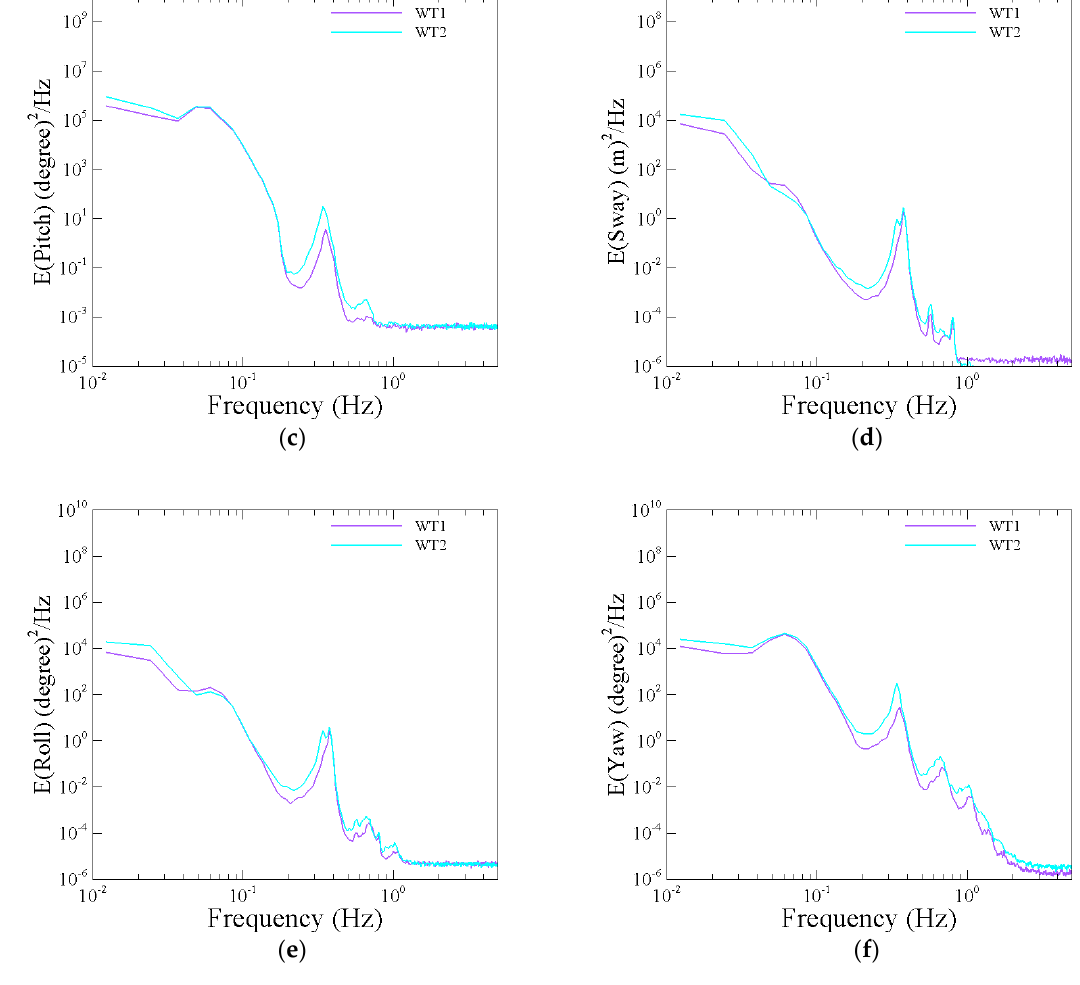
Figure 15. Spectra of platform motions of ( a ) surge, ( b ) heave, ( c ) pitch, ( d ) sway, ( e ) roll, and ( f ) yaw from SOWFA.